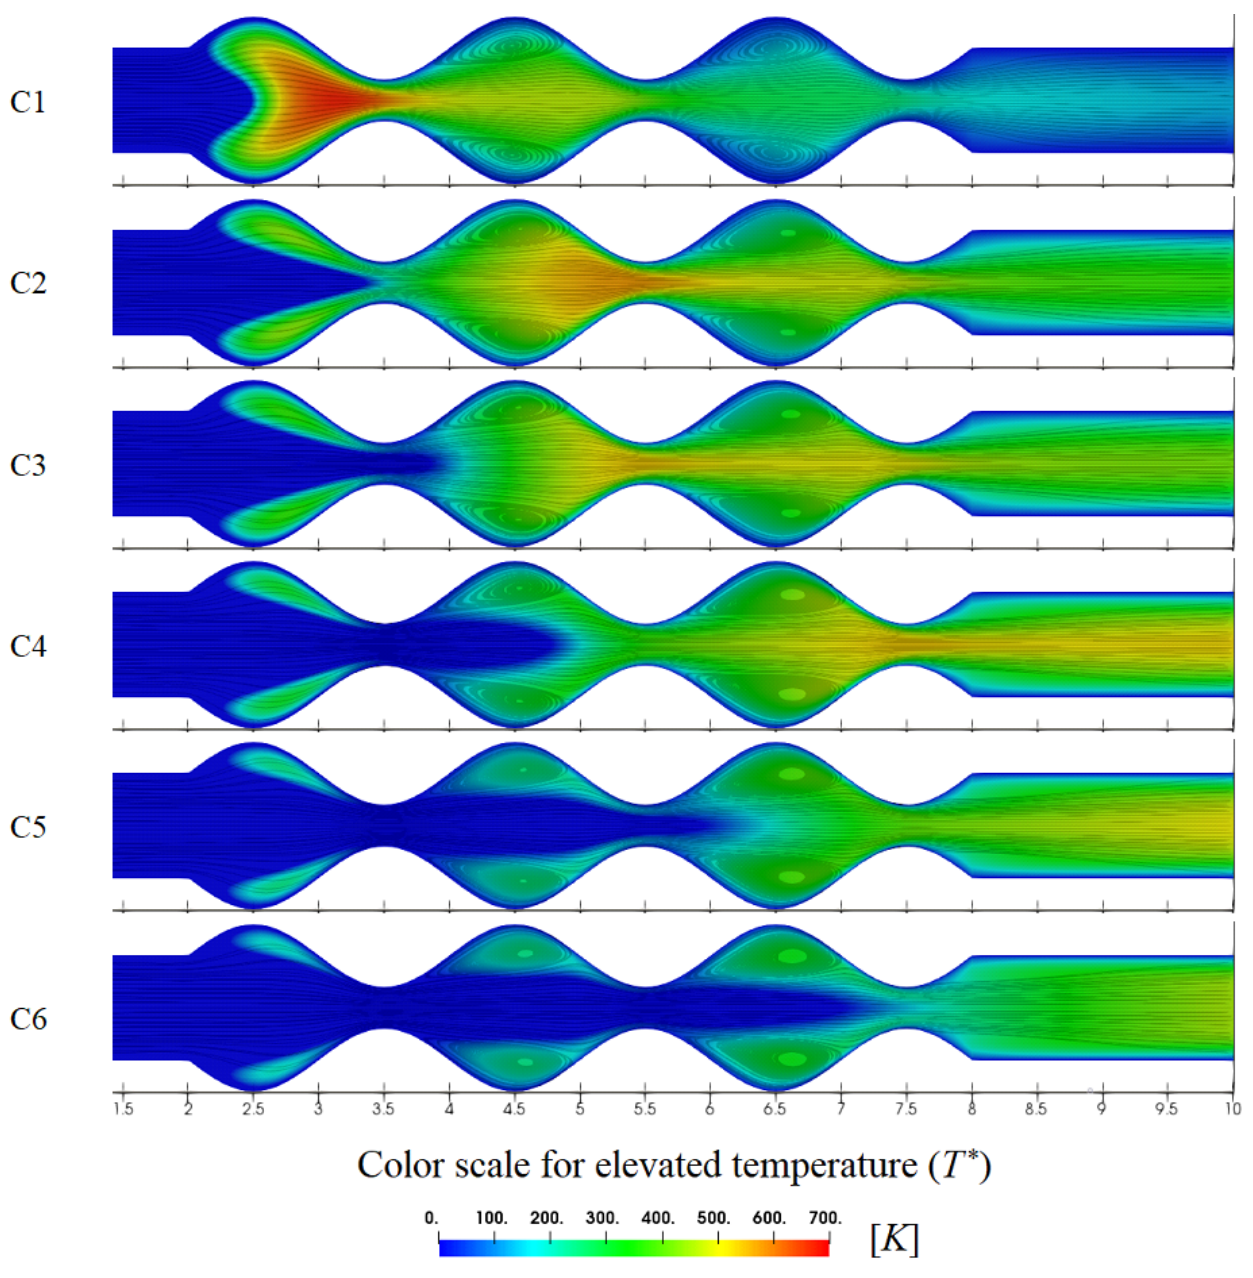
Figure 5. Contour maps for the streamlines superimposed on elevated temperature distribution for different